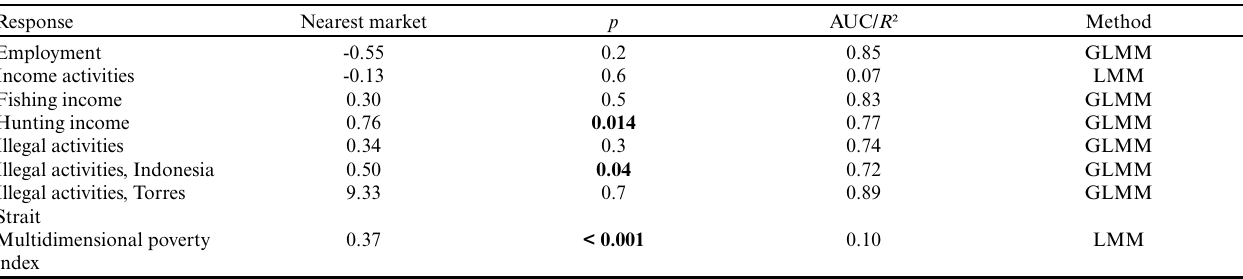
Table 2 . Linear mixed effects models that tested the relationships between household-level occupation, illegality, and poverty against the explanatory variable, distance to the nearest market. A random effect term was included for village. For each distance explanatory variable, the table shows the parameter estimate and significance. The methods used are linear mixed effects models (LMM) and generalized (logistic) linear mixed effects models (GLMM). Goodness of fit measures are R² (LMM) and area under the curve, or AUC (GLMM). Bold indicates a statistically significant relationship (p ≤